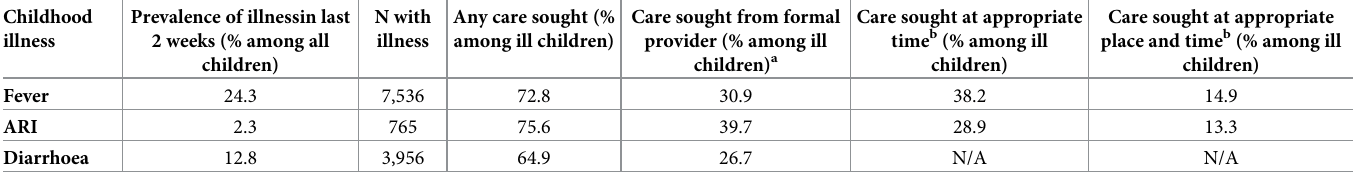
Table 2. Care-seeking behaviour among children with fever, ARI and diarrhoea. Childhood Prevalence of illnessin last illness 2 weeks (% among